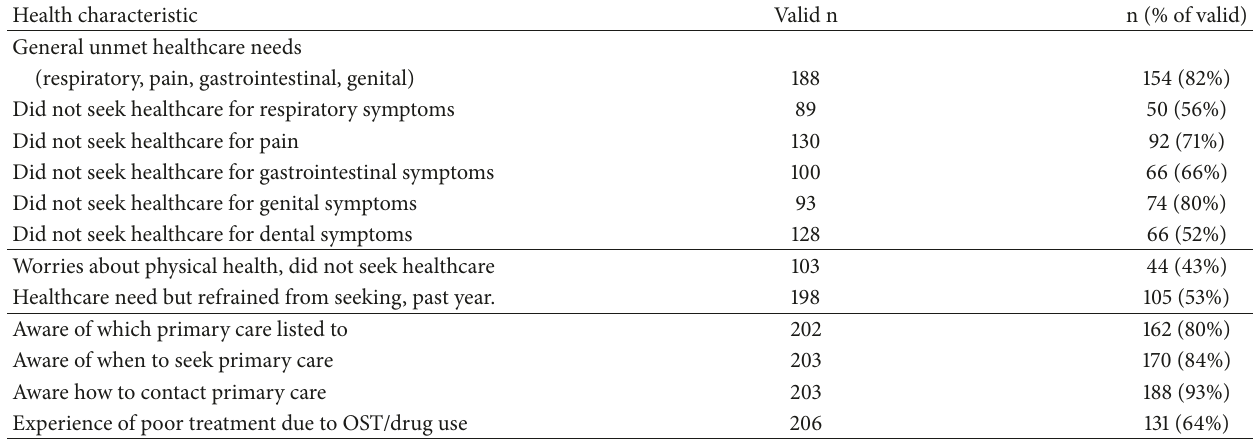
Table 3: Unmet healthcare needs . Total n=218. Percentage of valid answers. Excluded - no symptoms or missing answer.